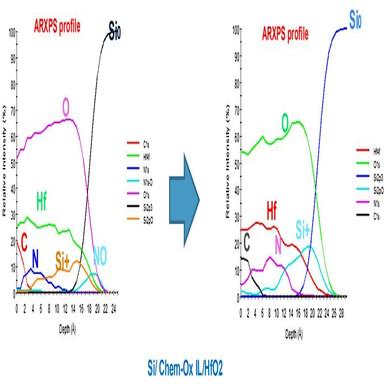
a. Normalized a.u. % ages as a function of angle for HfO2 /Chem-Ox IL (5A) after DPN; Fig. 4c. Depth profile result of Max Ent simulation of the data in Fig. 4a; Fig. 4b and d, as 4a and 4c, but for an equivalent wafer after PNA at 700C.